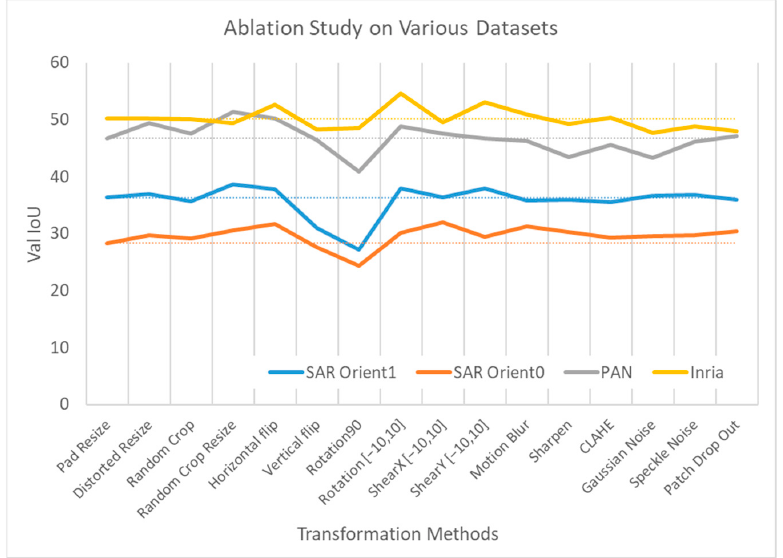
Figure 14. Results of the Ablation Study compared with three other datasets. SAR Orient 0 and PAN are from the same SpaceNet 6 dataset, while Inria is taken from the Inria Aerial Image Labeling dataset [7]. The IoU scores for the baseline method (Pad Resize) are marked with dotted horizontal lines for a straightforward comparison to other augmentation methods.